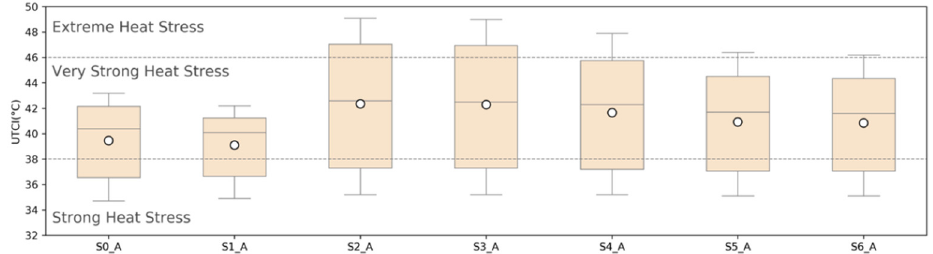
Figure 6. The UTCI level range of scenarios during simulation hours in shallow street canyons (indexed as A).